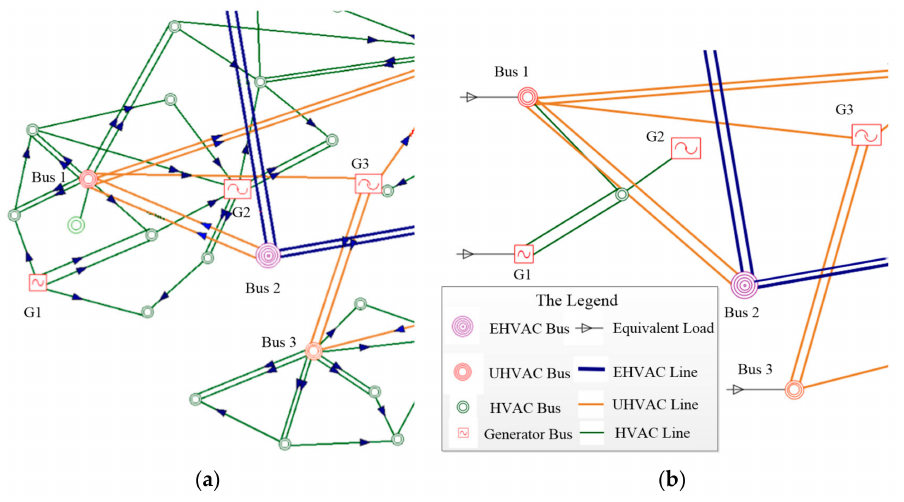
Figure 1. Reduction of power system. ( a ) Original power system; ( b ) Reduced power